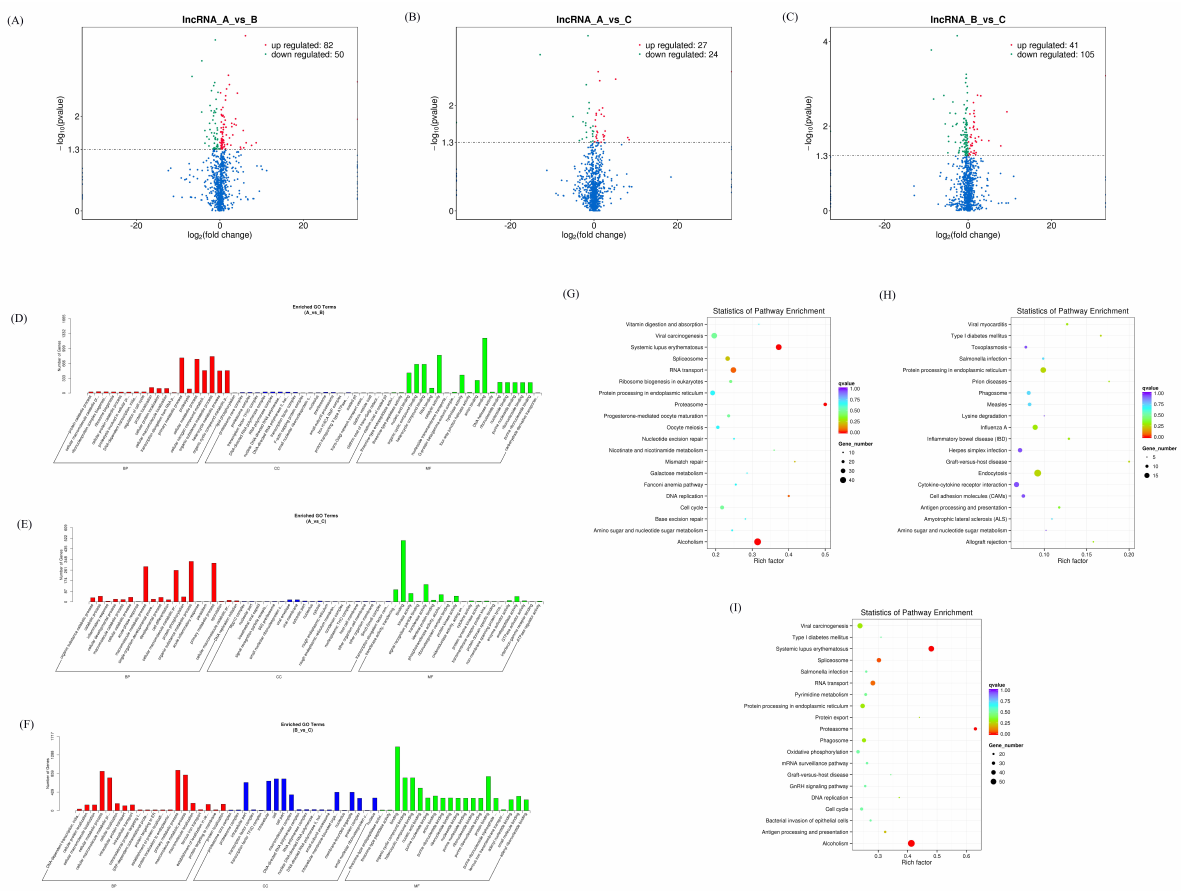
Figure 6. Expression profiles of differentially expressed lncRNAs. ( A – C ) Volcano plot of differentially expressed lncRNAs in AvsB group ( A ), AvsC group ( B ), and BvsC group ( C ). ( D – F ) GO analysis for neighbor gene functions of lncRNAs in AvsB group ( D ), AvsC group ( E ), and BvsC group ( F